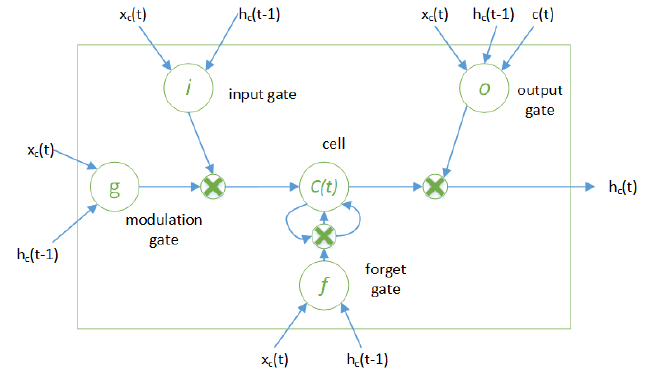
Figure 2. Basic structure of a recurrent neural network [20,22].